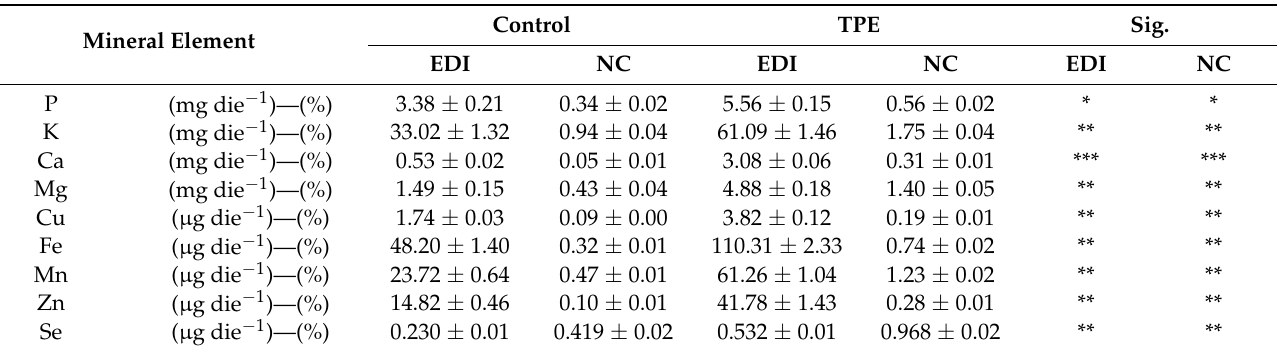
Table 4. Estimated Daily Intake (EDI) and Nutrient Contribution (NC) of San Marzano tomato fruits under control or tropical plant extract (TPE) treatments.